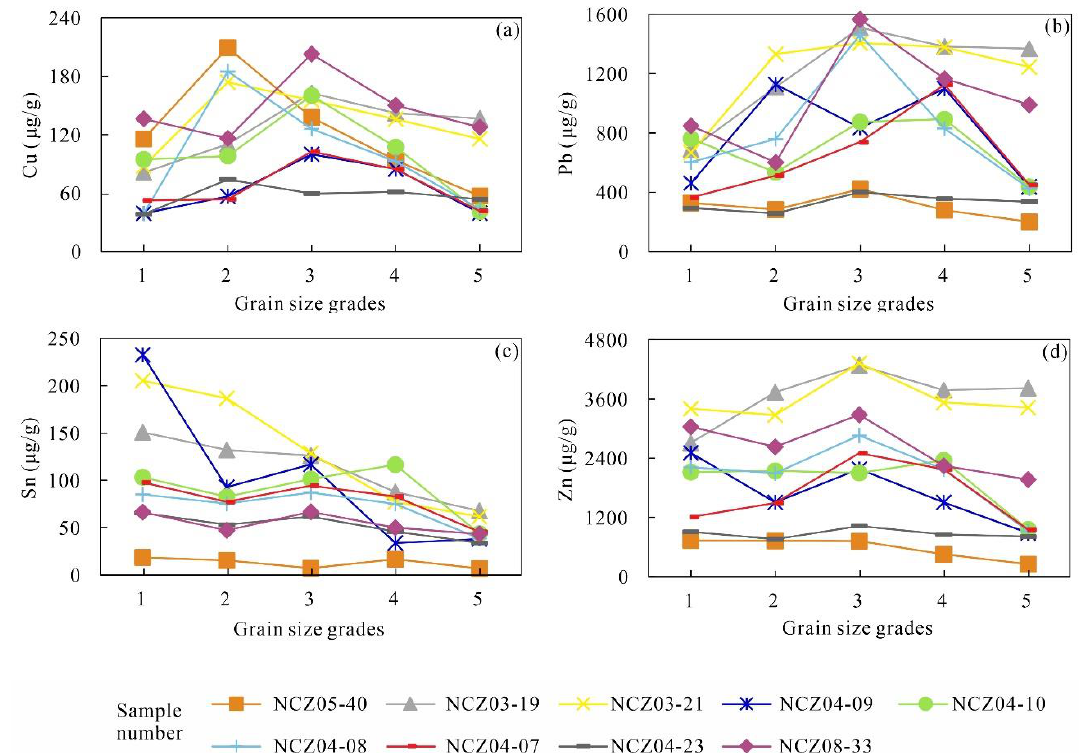
Figure 6. Values of different elements in different grain size grades. ( a ) Cu; ( b ) Pb; ( c ) Sn; ( d ) Zn.